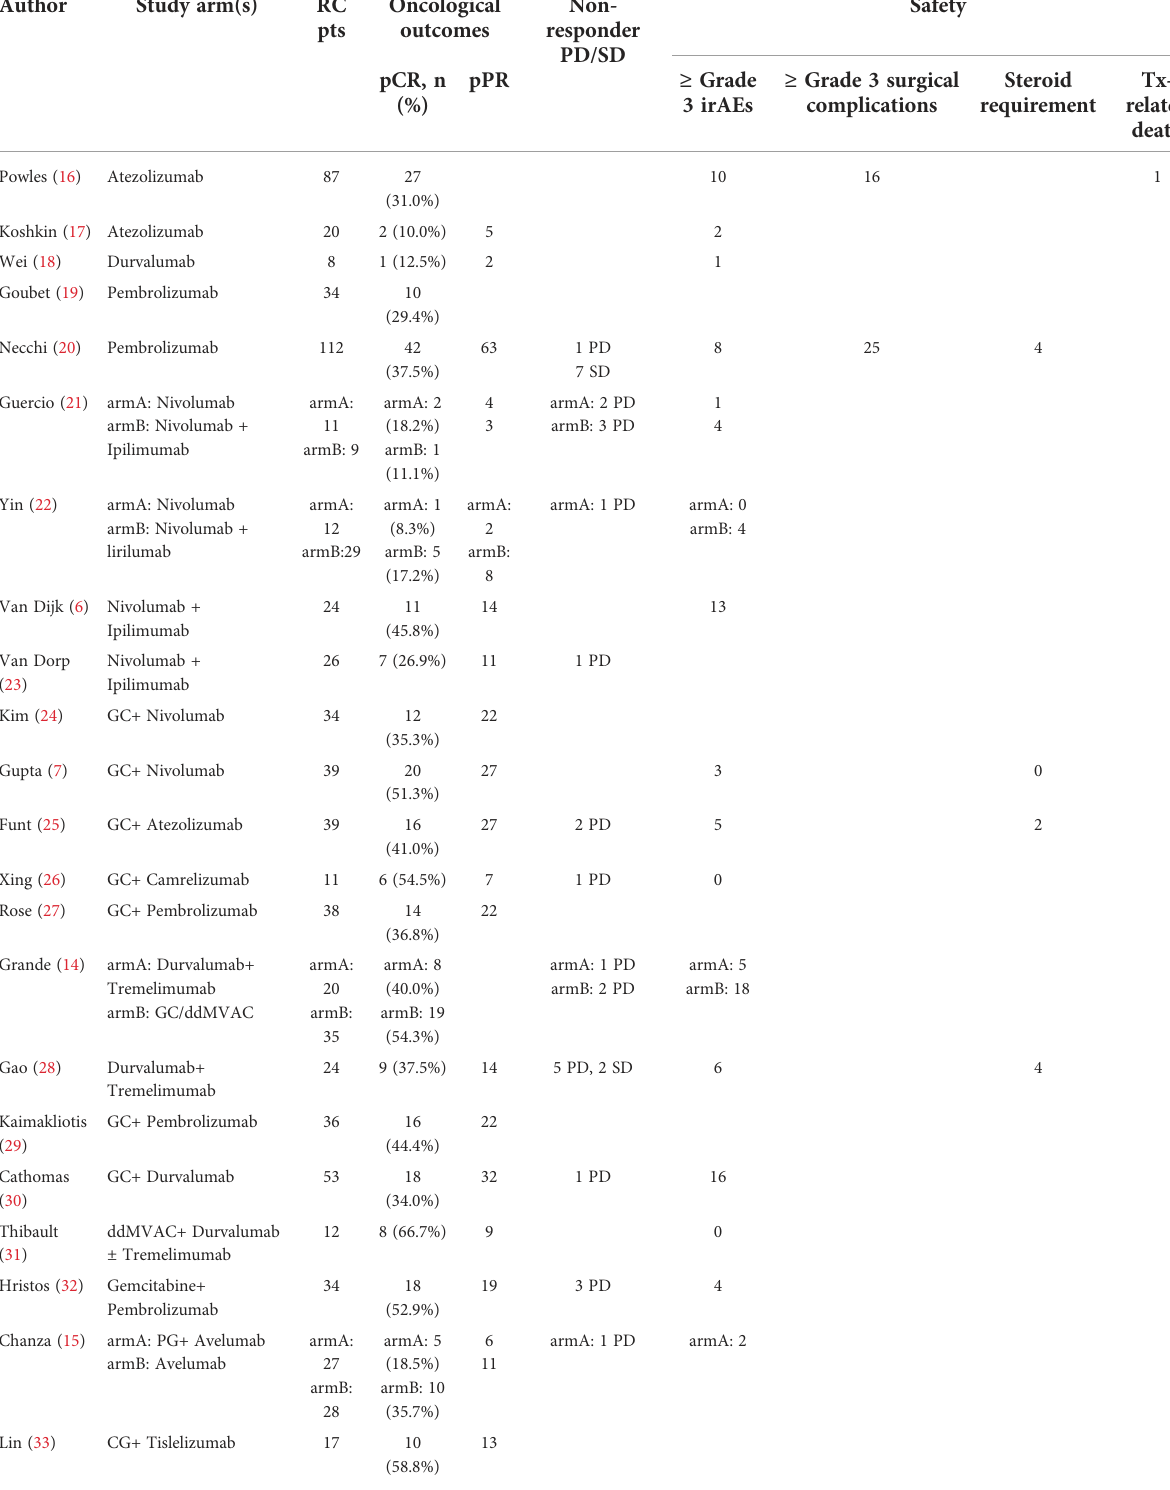
TABLE 2 Oncological and safety outcomes.